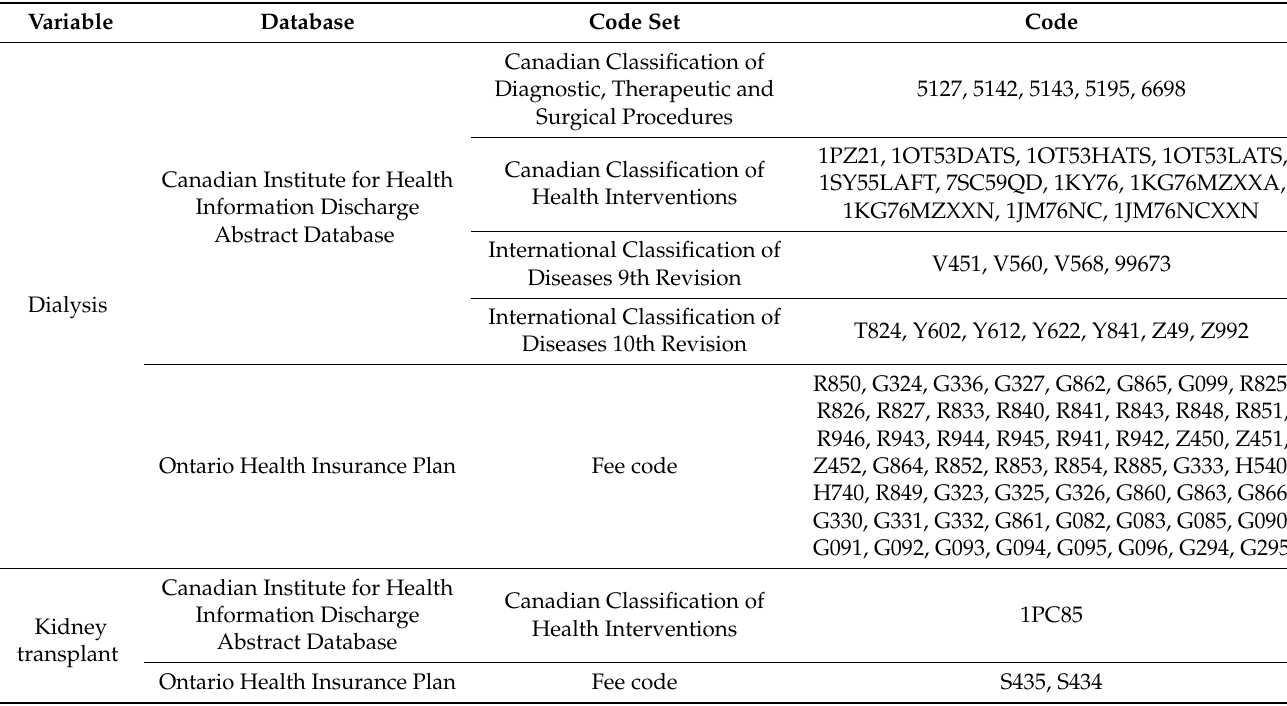
Table A4. Diagnostic codes for exclusion